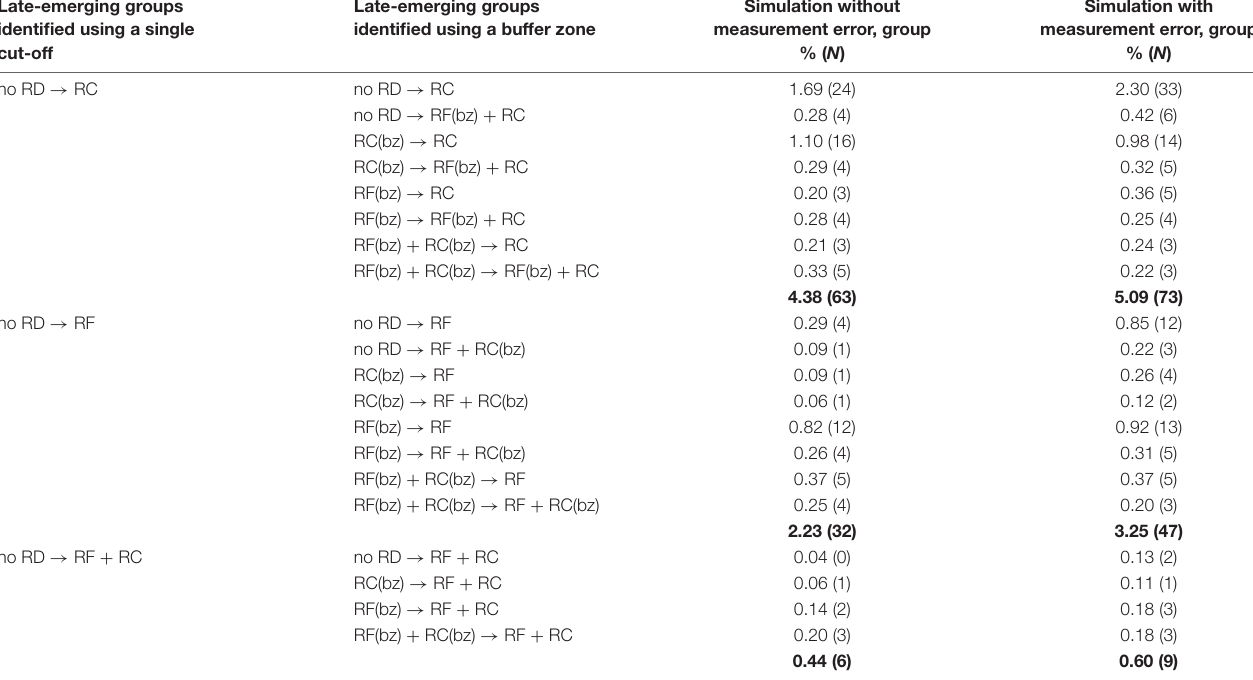
Late-emerging groups identified using a buffer zone